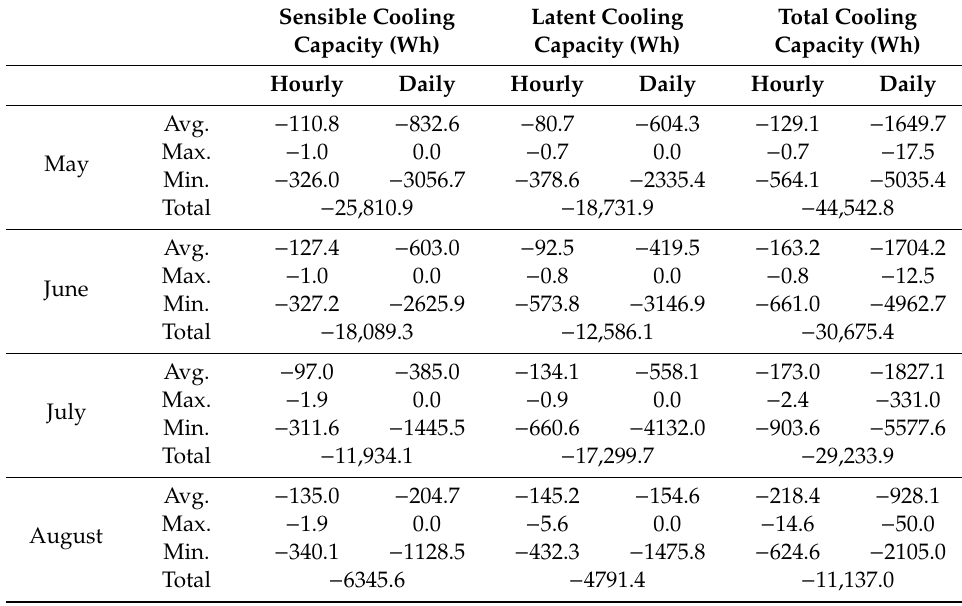
Table 3. Total cooling capacity, sensible cooling capacity, and latent cooling capacity of the